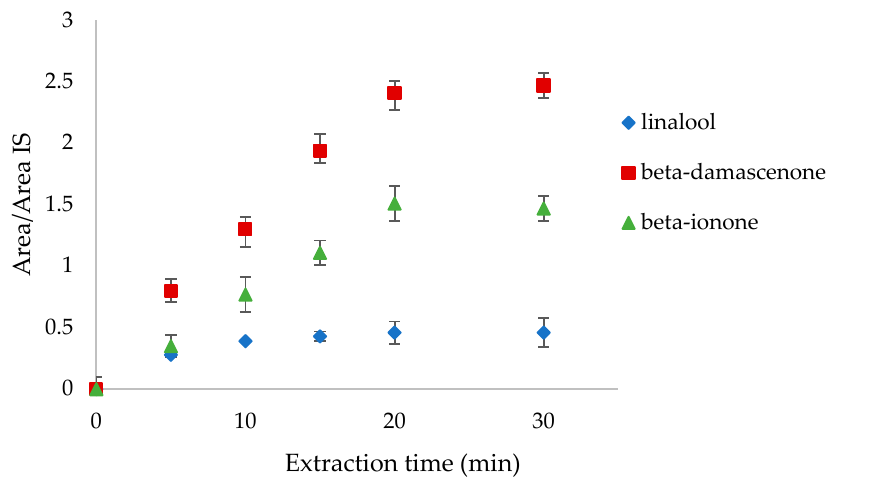
Figure 2. Extraction time tests on linalool, β -damascenone, and β -ionone at 5, 10, 15, 20, and 30 min.